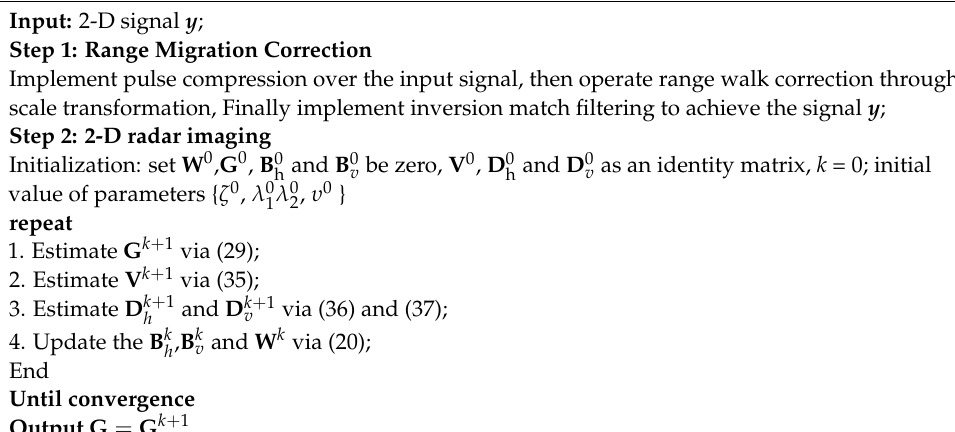
Algorithm 1. Procedure of the proposed MASB imaging